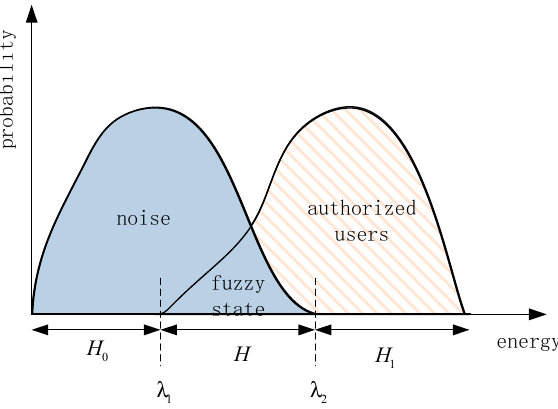
Figure 2. Energy distribution of noise and signal.